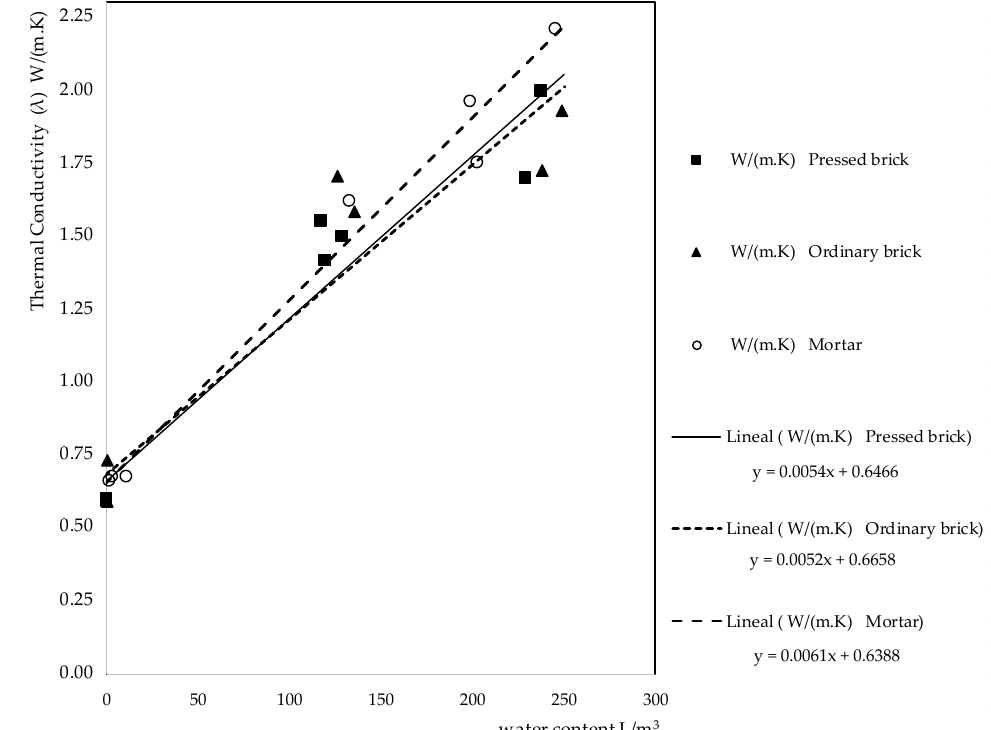
Figure 3. Thermal conductivity as function of water content of specimens.